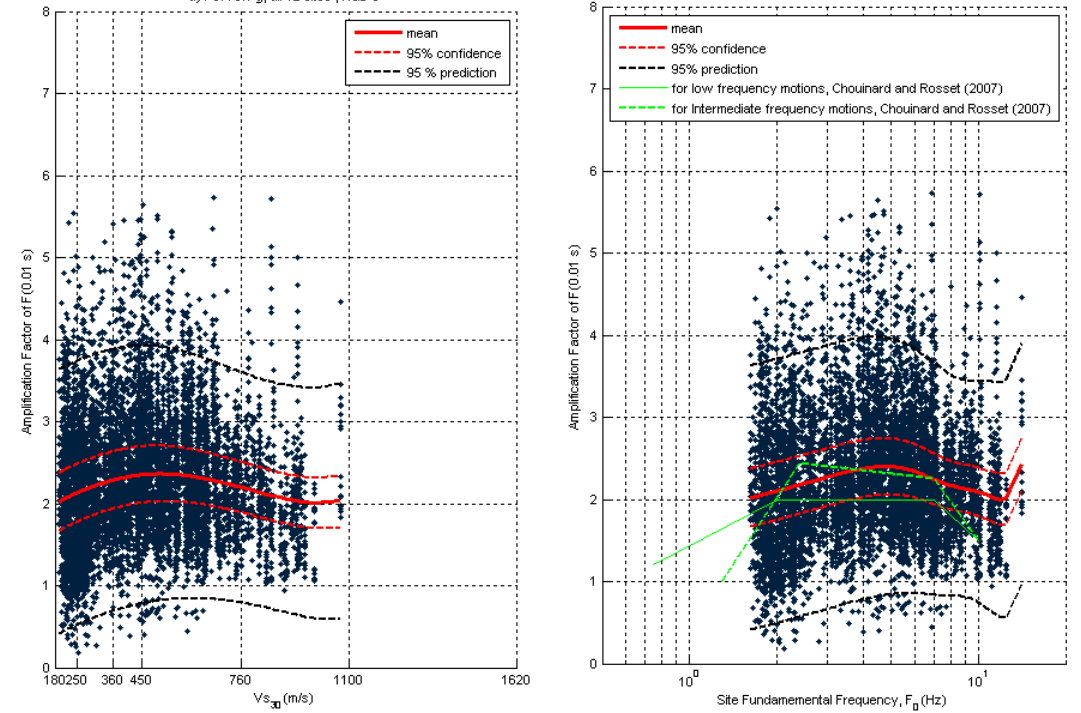
Figure 11. Amplification factors at T = 0.01 s for RQD of 3 (Vs = 2100 m/s) and PGA of 0.1 g: ( a ) as a function of Vs 30 , ( b ) as a function of site fundamental frequency F 0 .